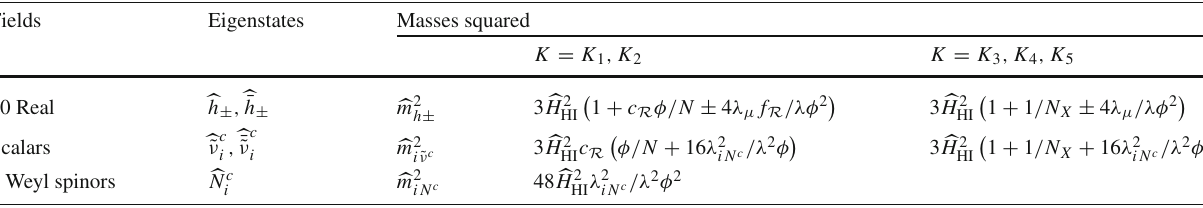
Table 3 Mass-squared spectrum of the non-inflaton sector for various K ’s along the path in Eqs. (27) and (59) Fields